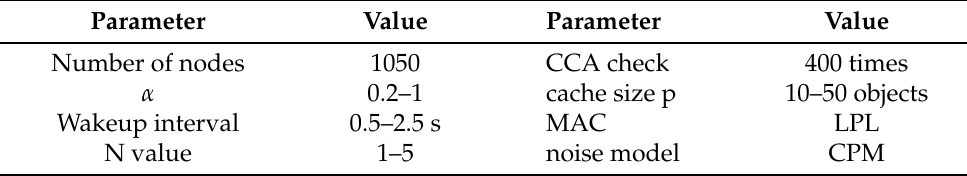
Table 2. Parameters.